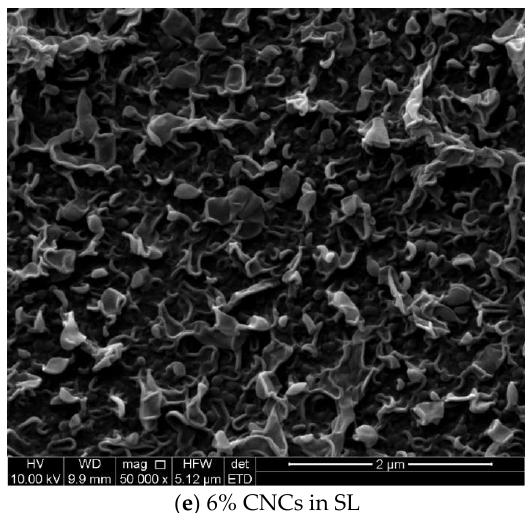
Figure 4. SEM images for the TFN membranes morphology that were synthesized on support layers of different CNCs gel filling ratios, ( a ) 0%, ( b ) 1%, ( c ) 2%, ( d ) 4%, and ( e ) 6%.